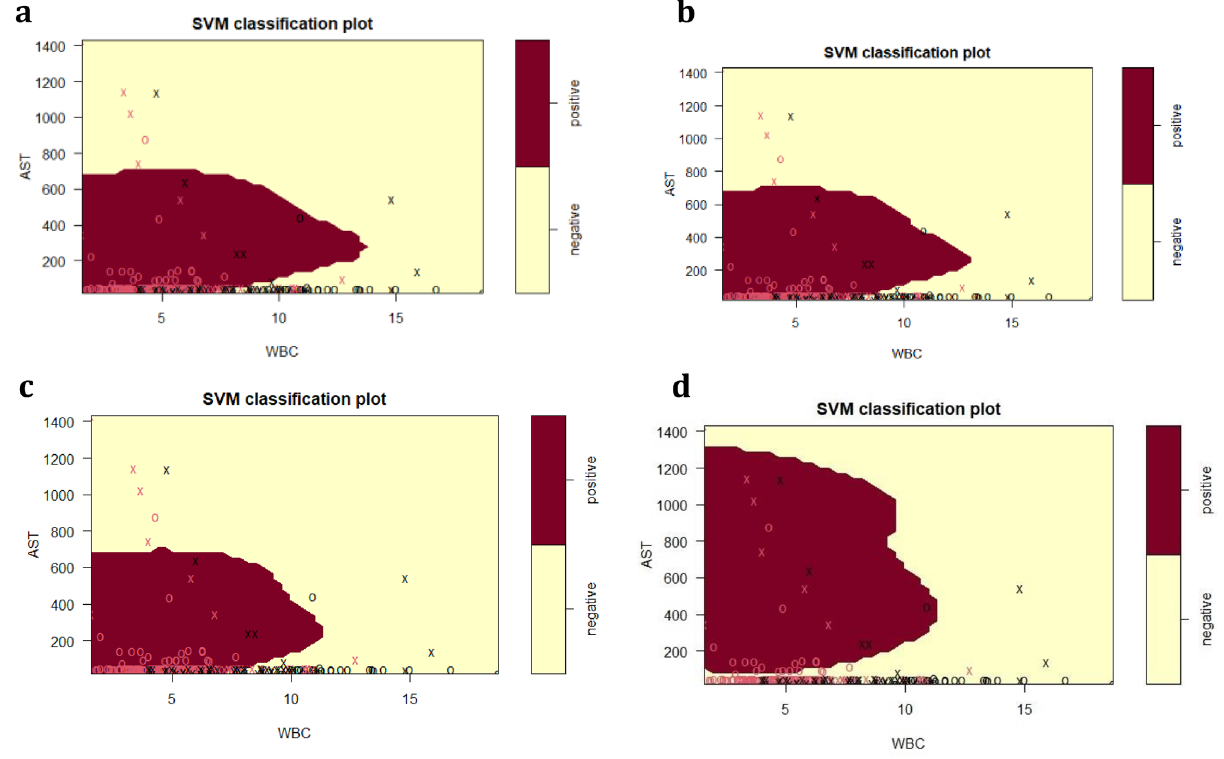
Figure 4. SVM plots describing the interaction of serum AST, WBC and serum ALT for the classification of HBsAg positive versus HBsAg negative results, as previously detected by specific HBsAg immunoassay. ( a ) ALT = 20 U/L; ( b ) ALT = 50 U/L; ( c ) ALT = 100 U/L; ( d ) ALT = 1000 U/L. The feature space assigned to HBsAg positive cases is shown in dark red, and the region assigned to negative cases is shown in light yellow. Crosses indicate the support vectors, and circles represent the remaining observations. The final SVM-based model of infection required to separate HBsAg positive from negative responses included the predictor (independent) variables AST (U/L), WBC (× 10 9 /L), age (years), ALT (U/L) and ALB (g/L): (cost = 4, gamma = 0.36, C-classification method and radial kernel). After tenfold training/testing of the data set, HBsAg positive immunoassay results were predicted at 88.2%, while negative results were predicted at at 78.2%, using the routine serum and blood markers AST, WBC, Age, ALT, as well as albumin. These top five predictor variables of HBsAg positive or negative immunoassay results from the tree analyses subsequently pro- vided the model for calculations of prediction accuracy. The model was further assessed on accuracy (85.4%), sensitivity (91.0%), specificity (72.6%), precision (88.2%), F1-score (0.89), and AUC (0.90). The ROC curve showing the discrimination measure of the model is presented in Supplementary Figure S1. The relationship between AST and WBC were plotted for Figs. 4 and 5, with slices introduced into the models for ALT (20– 1000 U/L, Fig. 4) and age at the time of HBsAg immunoassay testing (15–65 years, Fig. 5). ALT kinetics associated with the primary predictor variables AST and WBC. For the SVM plots presented in Fig. 4, the dark red area represents the areas of HBsAg positive prediction, and the light yellow represents HBsAg negative prediction. A serum ALT of 20 U/L (Fig. 4a) is well below the upper limit of the NIMR reference inter- val, and therefore represents early phases of initial HBsAg positive infection, prior to liver damage. For Fig. 4a and Fig. 4b,c,d, a pronounced relationship between AST and WBC was detected, which interacted with ALT, as demonstrated by the alterations in AST–WBC relationship with increasing serum concentrations of this enzyme. For Fig. 4 (a,b,c), while the upper range of AST stayed at approximately 700 U/L, two features of the HBsAg population (dark red) were pronounced with the increase of ALT from 50 to 1000 U/L. First was the decrease